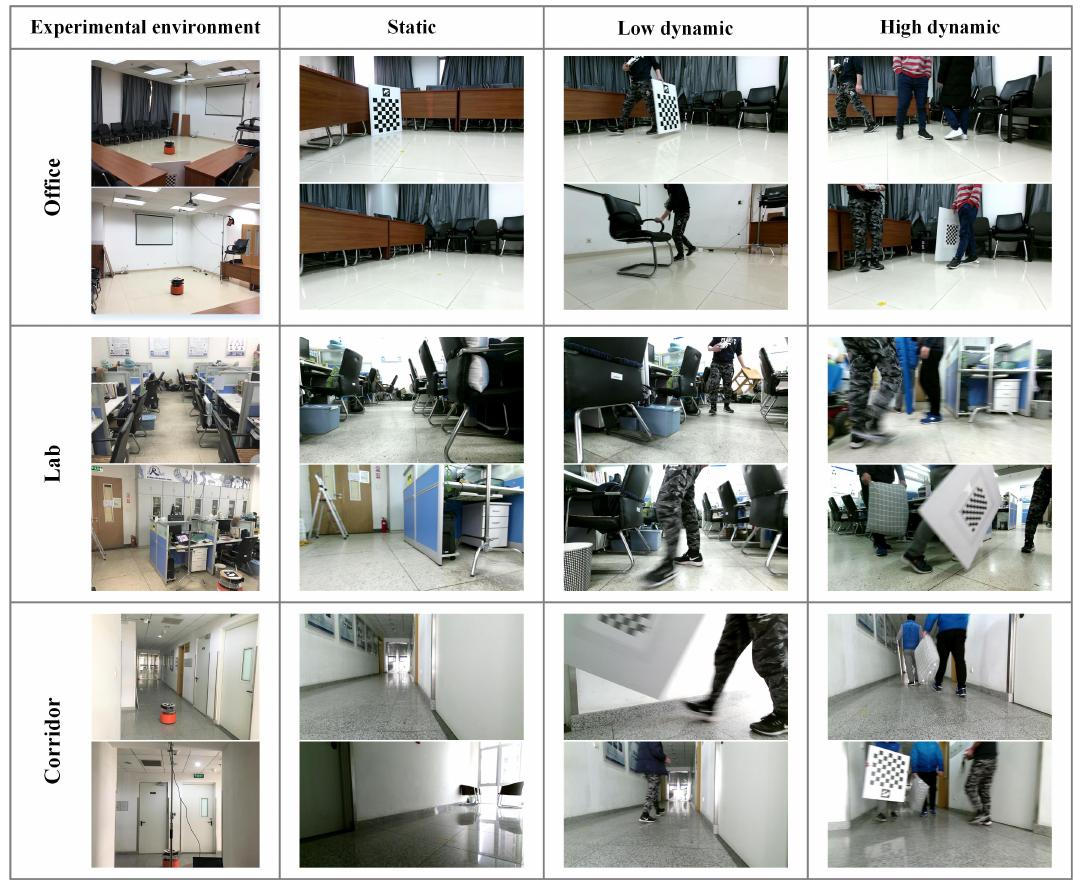
Figure 8. Experimental environments and RGB images in the static, low dynamic, and high dynamic data